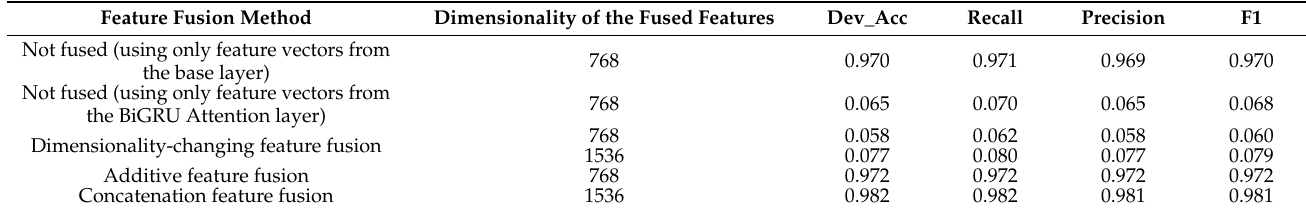
Table 5. Feature fusion strategy ablation